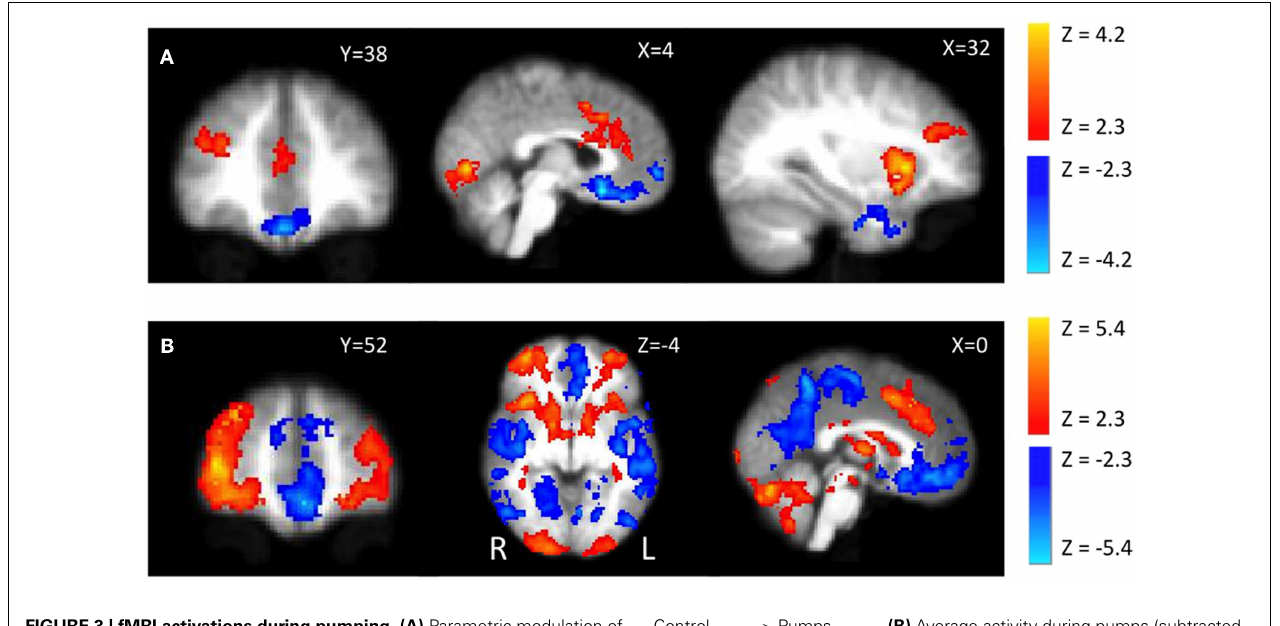
Control Parametric > Pumps Parametric. (B) Average activity during pumps (subtracted by the average activity of pumping the control balloon). Red scale presents Pumps Avergae > Control Average and blue scale presents Control Average > Pumps Average .